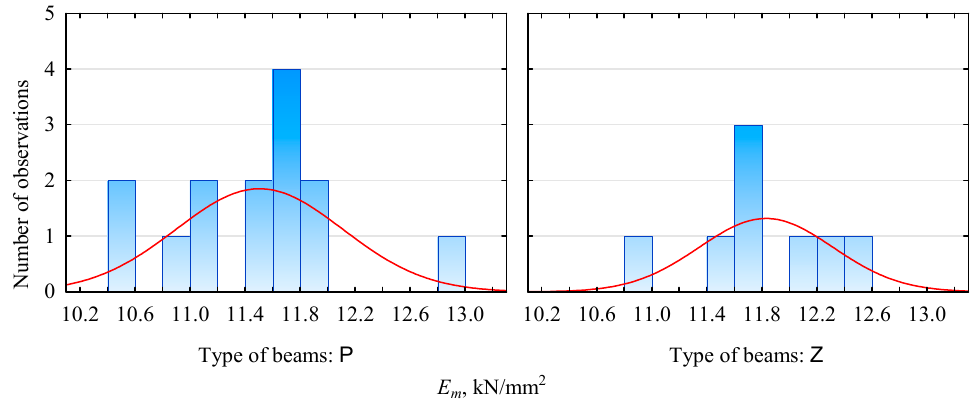
Figure 3. Modulus of elasticity distribution for beams manufactured with the face of visually graded lumber.